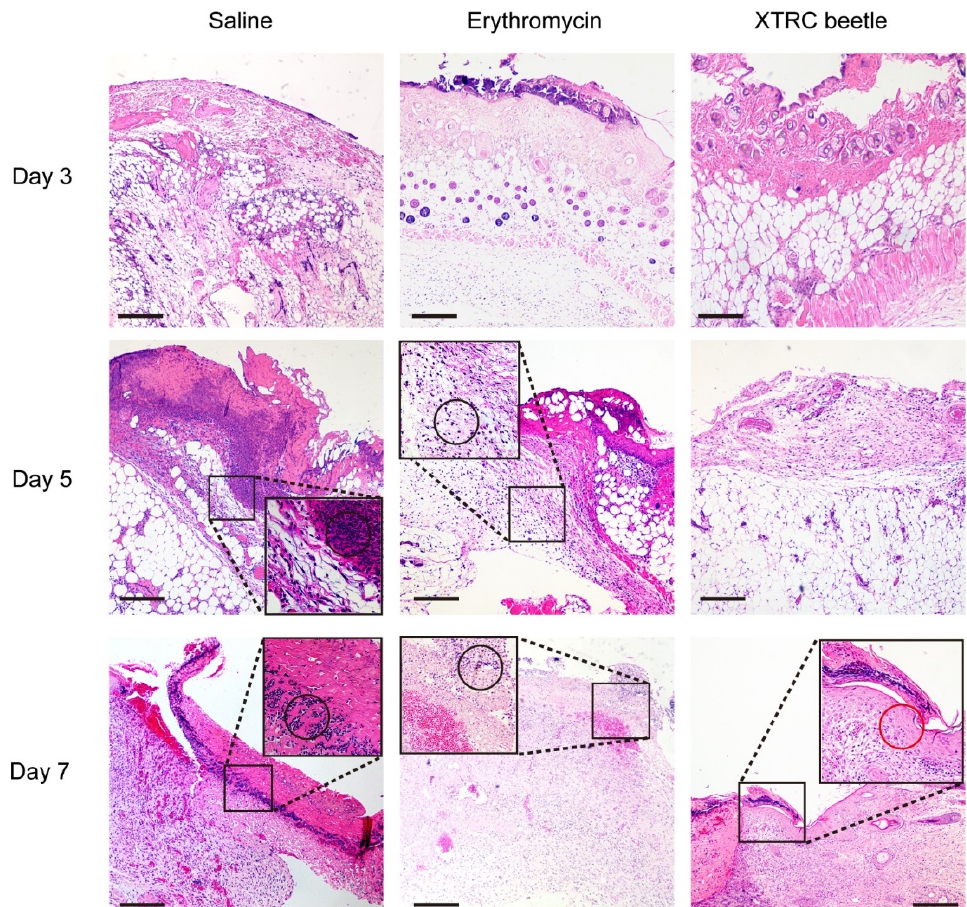
Figure 3. Representative images of hematoxylin and eosin (HE) stained histological sections of wound healing tissues from infected mice treated with erythromycin ointment or Z. morio hemolymph, and infected untreated mice on days 3, 5, and 7 after infection. The squares indicate the enlarged area, the black circles represent inflammatory cells, and the red circles represent the new epidermis. Scale bars, 300 μ m, n = 4.